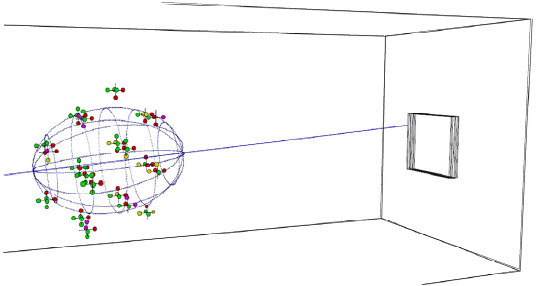
Figure 3. An example of the cluster of 20 QSMs with maximal responses.